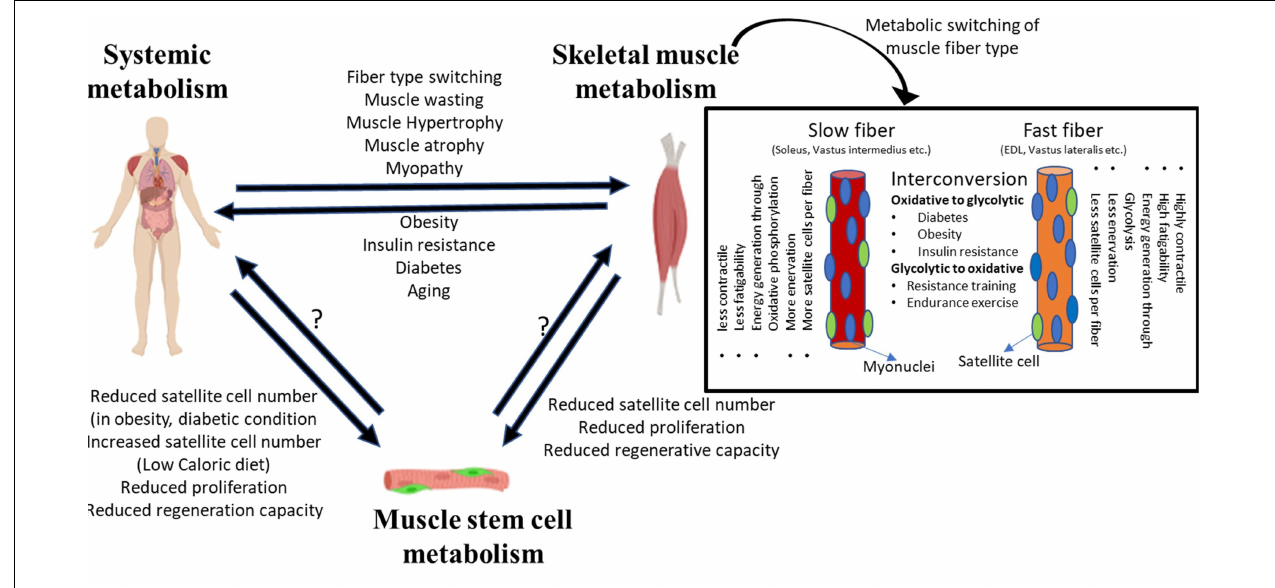
FIGURE 1 | System level metabolism is tightly linked to skeletal muscle metabolism. Alterations in system level metabolism due to stress or pathological conditions can affect muscle physiology. Systemic metabolism can alter the fiber-type composition of muscle, wherein different fiber types depict distinct metabolic state and affect the overall physiology. Similarly, changes in skeletal muscle homeostasis can induce system level pathologies such as obesity, diabetes, etc. Disruption or alteration of systemic or muscle tissue metabolism can extend to MuSCs. While the evidence is limited, stressed/dysfunctional MuSCs may potentially impact tissue level or system level metabolic